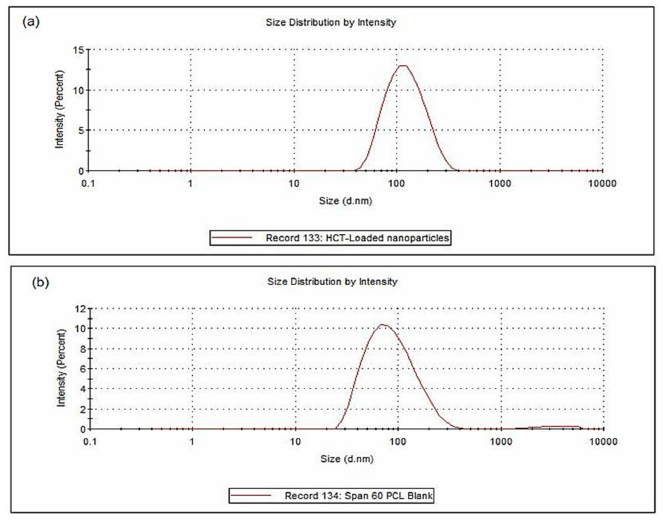
Figure 3. Nanoparticle size of ( a ) HCT-loaded and ( b ) SMS-PCL blank